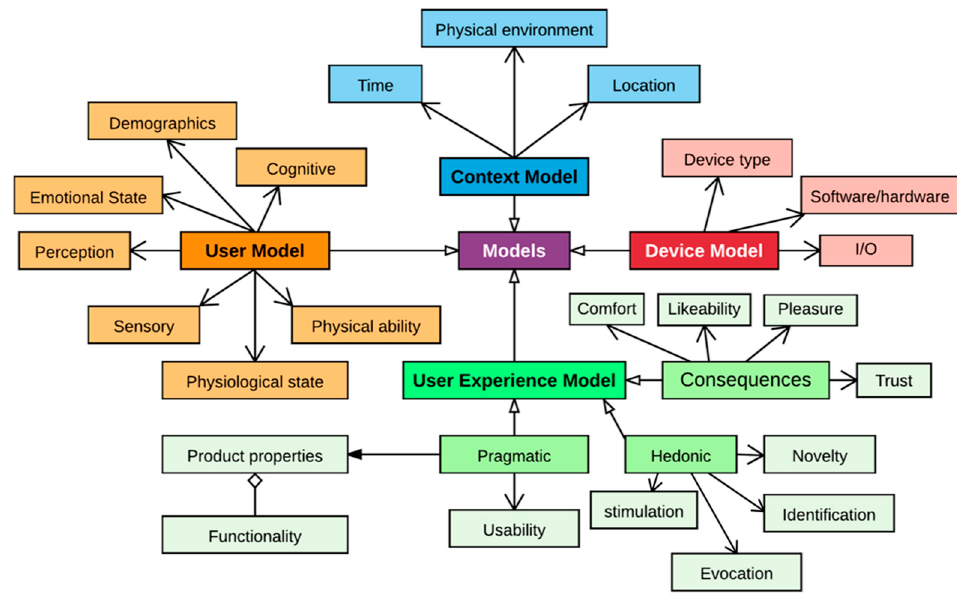
Figure 4. Lean UX Model.